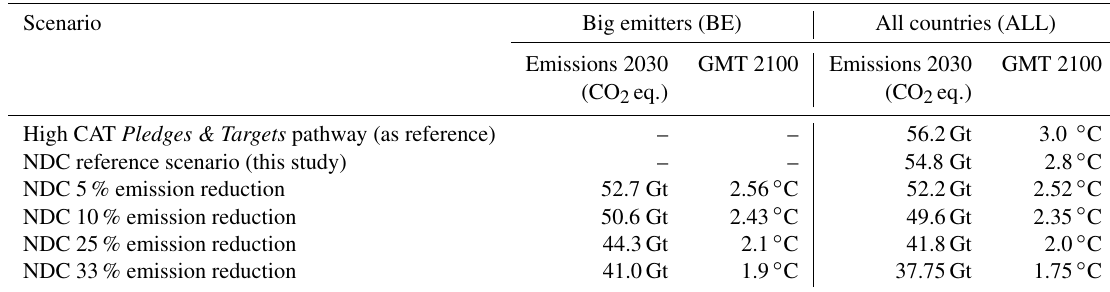
Figure 1. Historical and annual global greenhouse gas (GHG) emission and global mean temperature (GMT) trajectories for the NDC reference scenario and two NDC improvement scenarios with a 10% and 33% reduction of 2030 emission levels relative to the NDC reference. Scenarios for big emitters are labelled “BE” and scenarios for all countries using “ALL”. Also shown is the observed global temperature change based on the HadCRUT4 (solid grey) and BEST (dashed grey) datasets (REF). All GMT estimates are provided relative to the 1850–1900 average. Annual global GHG emissions are provided in gigatonnes of CO 2 equivalent (GtCO 2eq . ). Table 1. Overview of the evaluated scenarios, including details on projected global greenhouse gas emissions for the year 2030 and the projected median increase in global mean temperature (GMT) for the year 2100 relative to 1750. The emission reduction levels in 2030 are applied to either only big emitters (BE) or all countries